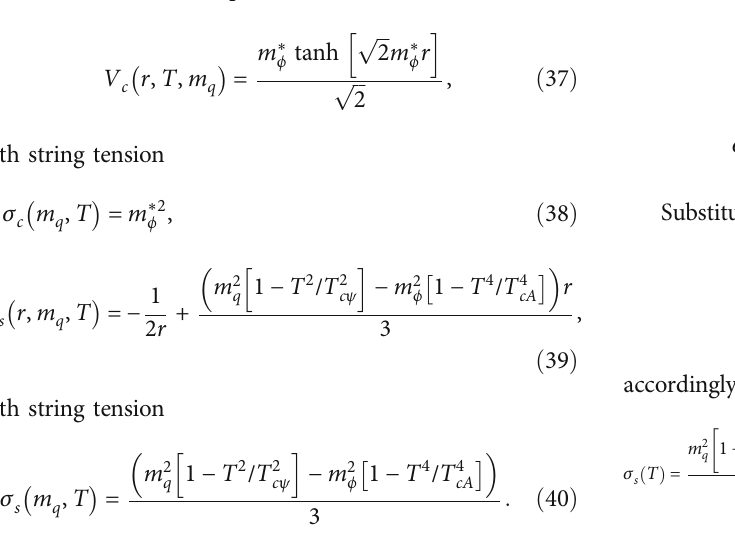
ffiffiffiffiffiffiffiffiffiffiffiffiffiffiffiffi p 3 / − 3+ m 2